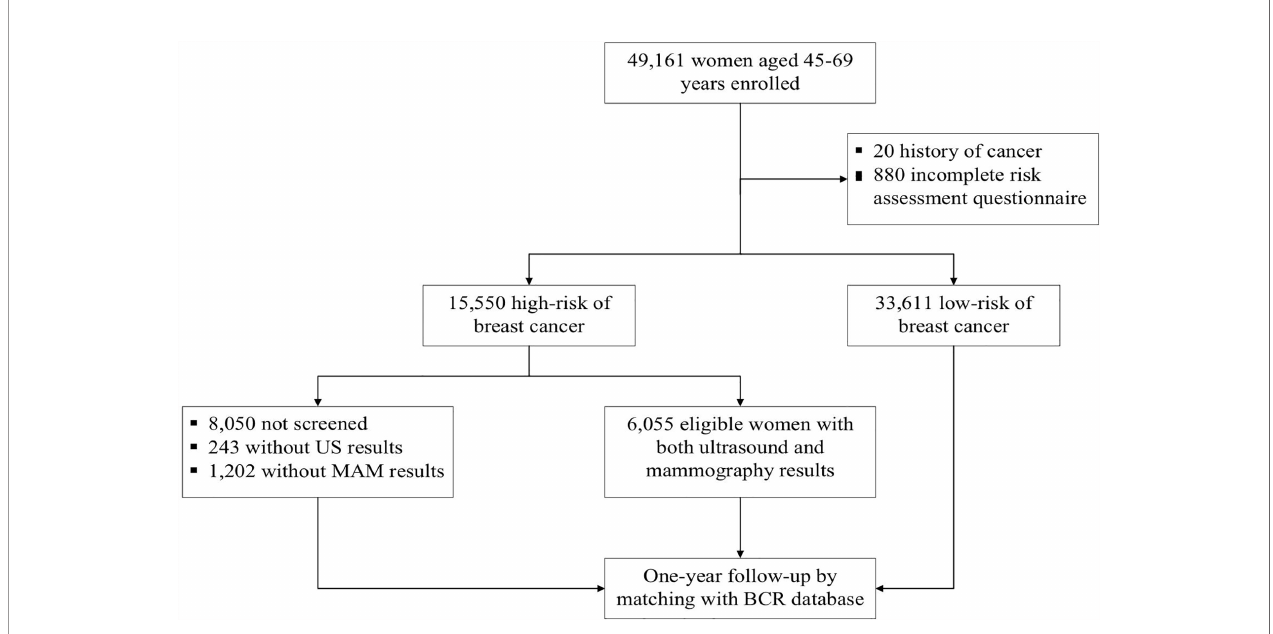
FIGURE 1 | Study fl owchart of participant ’ s enrollment, screening and follow-up of breast cancer screening in BCSPCS,